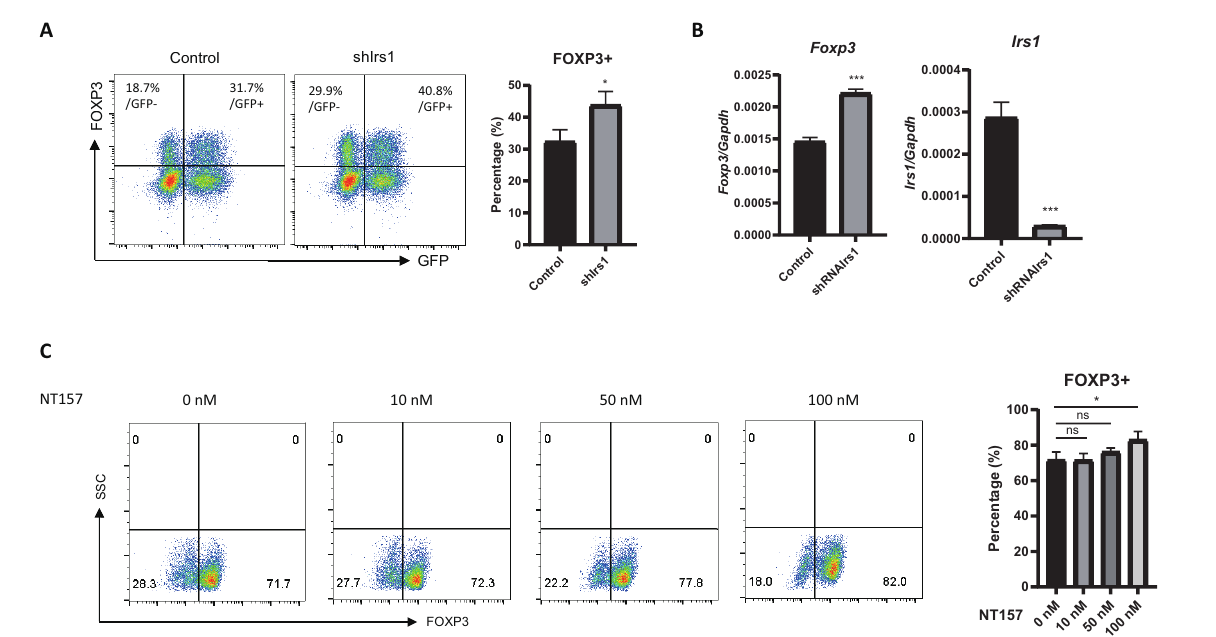
Figure 3. Knockdown or pharmacological inhibition of IRS1 enhances Treg cell differentiation. ( A ) Naïve CD4 T cells isolated from C57BL/6J mice were cultured for 1 day under Th0 conditions and then transduced with the shRNA-Irs1 vector. Cells were then cultured for 2 days under suboptimal Treg-inducing conditions. GFP+ cells were used for transduction. FOXP3 expression was measured via flow cytometry. ( B ) Irs1 and Foxp3 mRNA levels. Expression was measured via qRT-PCR and normalized to that of Gapdh . ( C ). Naïve CD4 T cells were cultured under Treg-inducing conditions in the presence of NT157 for 3 days, and the percentages of Foxp3-expressing cells were measured via flow cytometry. All data are representative of three independent experiments. The bar graph next to the flow cytometry plot shows data pooled from three independent experiments. The error bars represent the SD, and ( A , B ) p -values were calculated using a t -test. ( C ) p -values were calculated using one-way ANOVA/Tukey test. * p < 0.05, *** p < 0.001. ns: not significant.